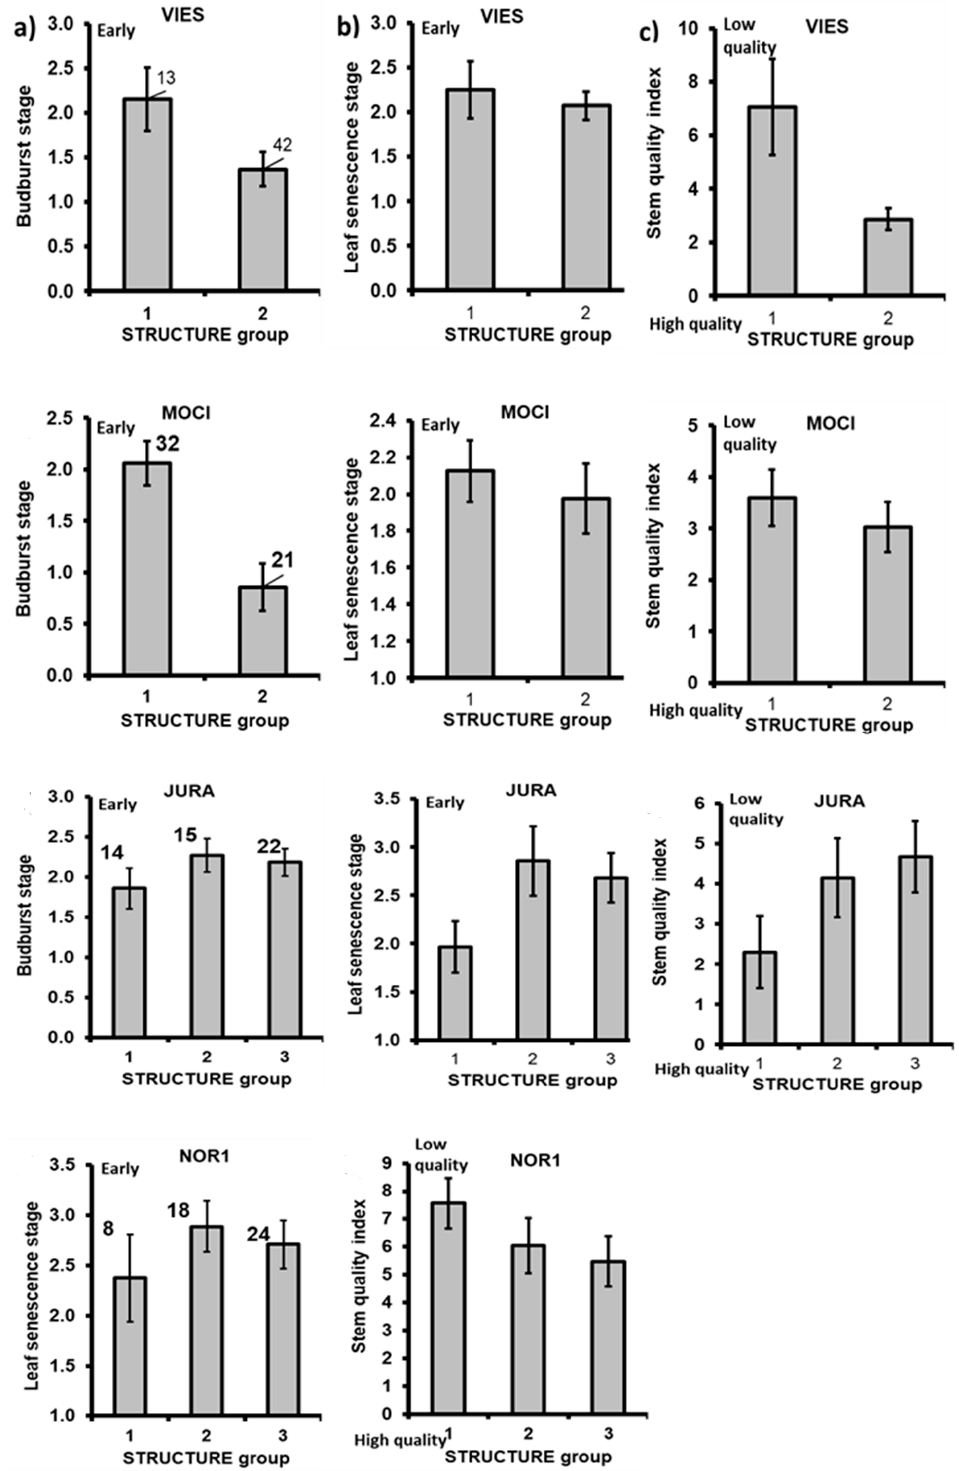
Figure 4. Properties of the STRUCTURE genetic groups in the four stands of European beech. For each stand separately the plots ( a , b ) indicate the phenology traits and plots ( c )–the stem quality. The size of the genetic groups is indicated above the bars in the plots ( a ). The error bars show standard errors.